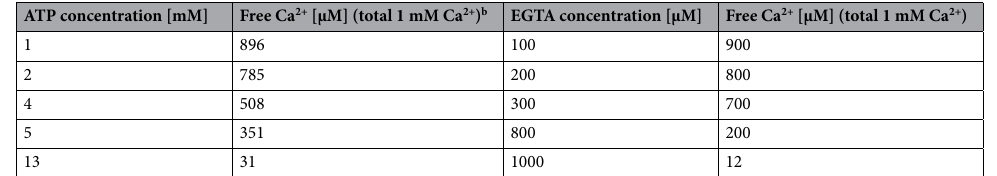
Table 1. Calibration of free Ca 2+ concentration in the presence of ATP or EGTA a . a The MaxChelator simulation program was used to calculate free Ca 2+ concentration in the presence of ATP or EGTA. b 1 mM Ca 2+ , 5 mM Mg 2+ , and 10 μM